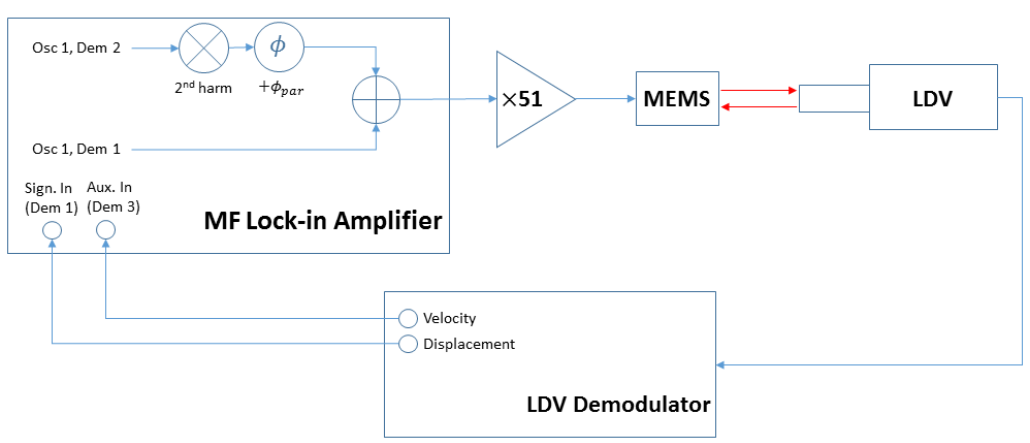
Figure 2. Schematic diagram for measurement. A multi-frequency lock-in amplifier is used to generate the output signal to the micro-electro-mechanical systems (MEMS) and to detect the displacement and velocity signals from the